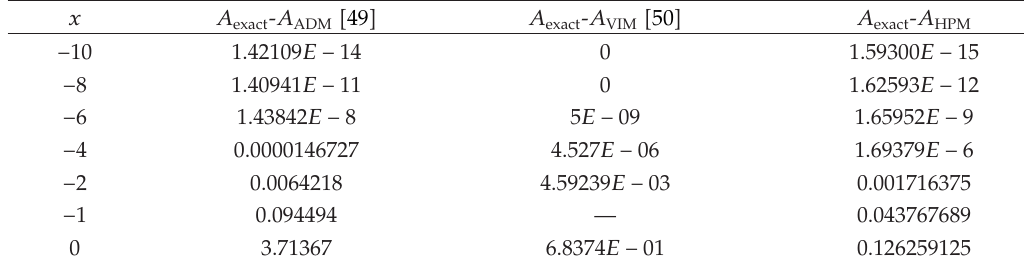
A (cid:6) 50 (cid:7) A exact - VIM